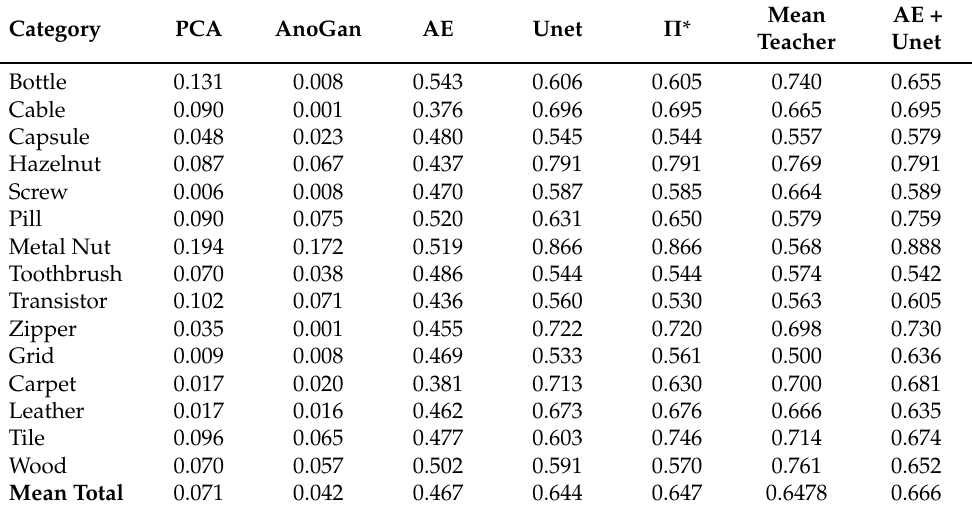
Table 2. Semantic segmentation performance of several evaluated methods. We report the IoUs of unsupervised PCA, unsupervised AnoGan, unsupervised autoencoder (AE), Unet, pi models ( Π * ), mean teacher, and our method (AE + Unet).